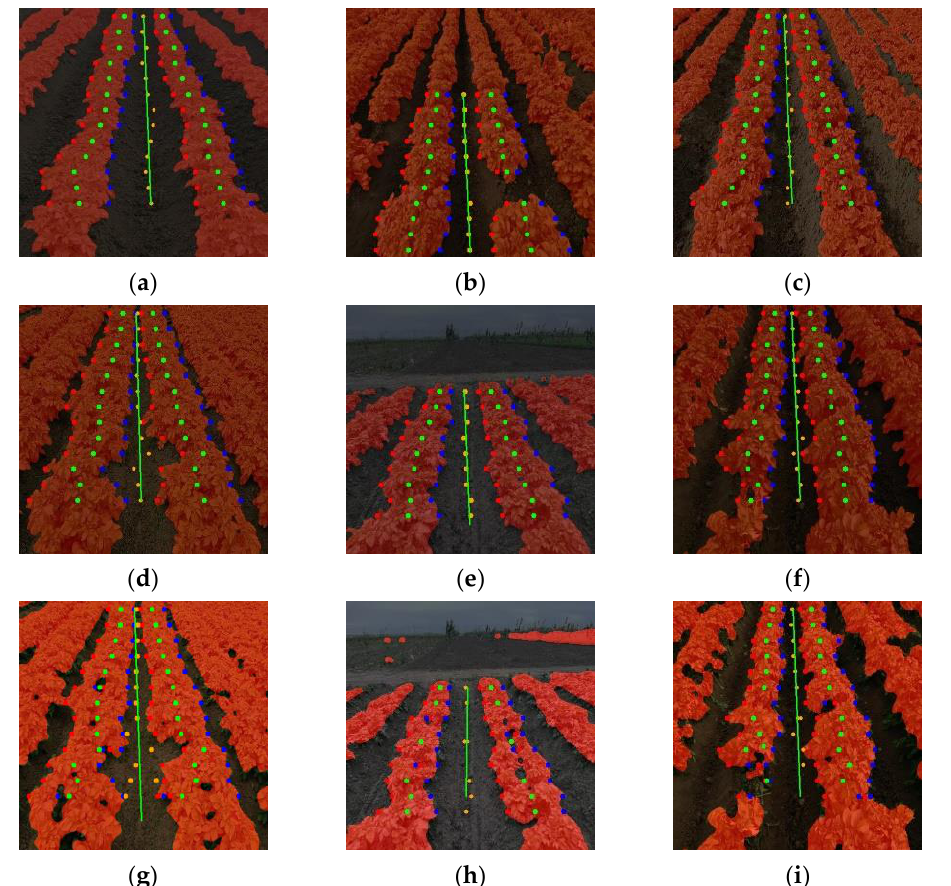
Figure 12. Comparison of segmentation effects under different working conditions: ( a – f ) the methods described in this paper; ( g – i ) the traditional methods.